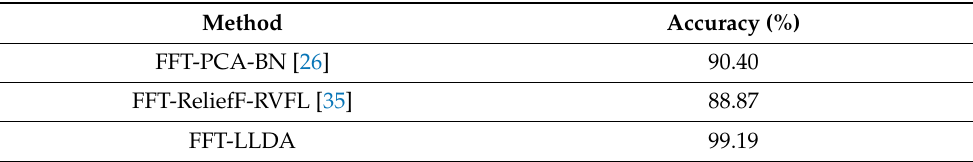
Table 5. Accuracy of different diagnosis